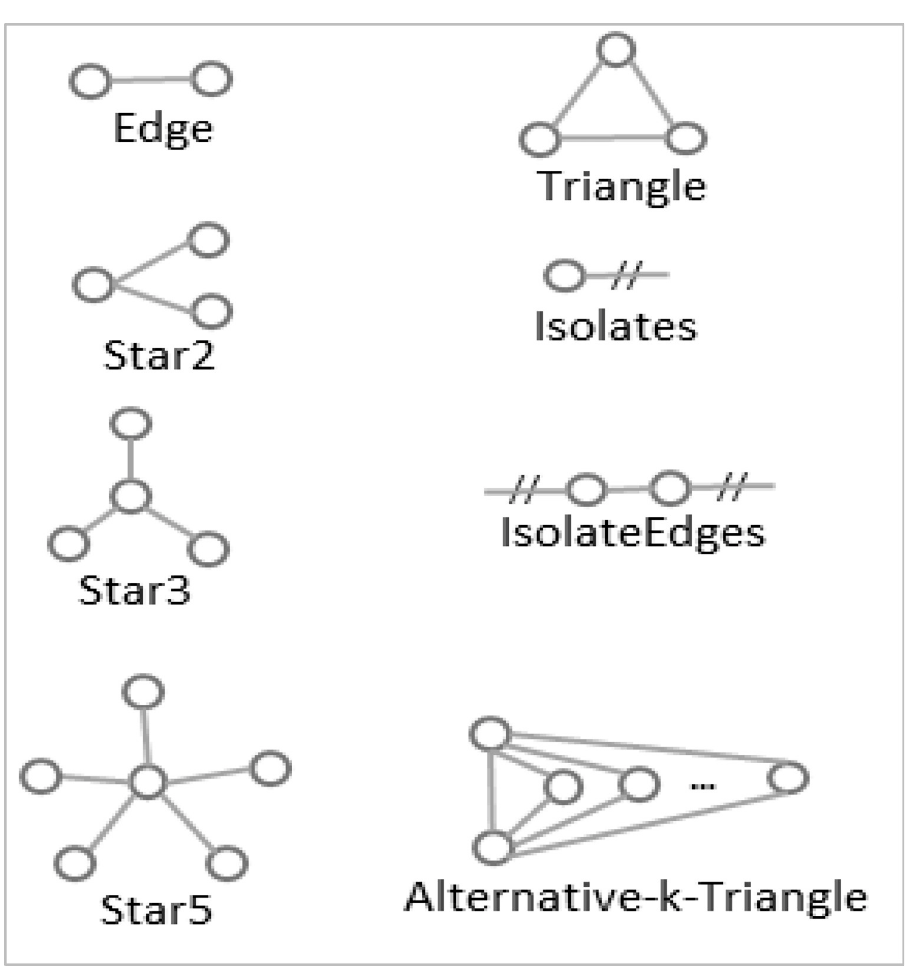
Fig 5. Microstructures or configurations of the exponential random graph model are considered in this